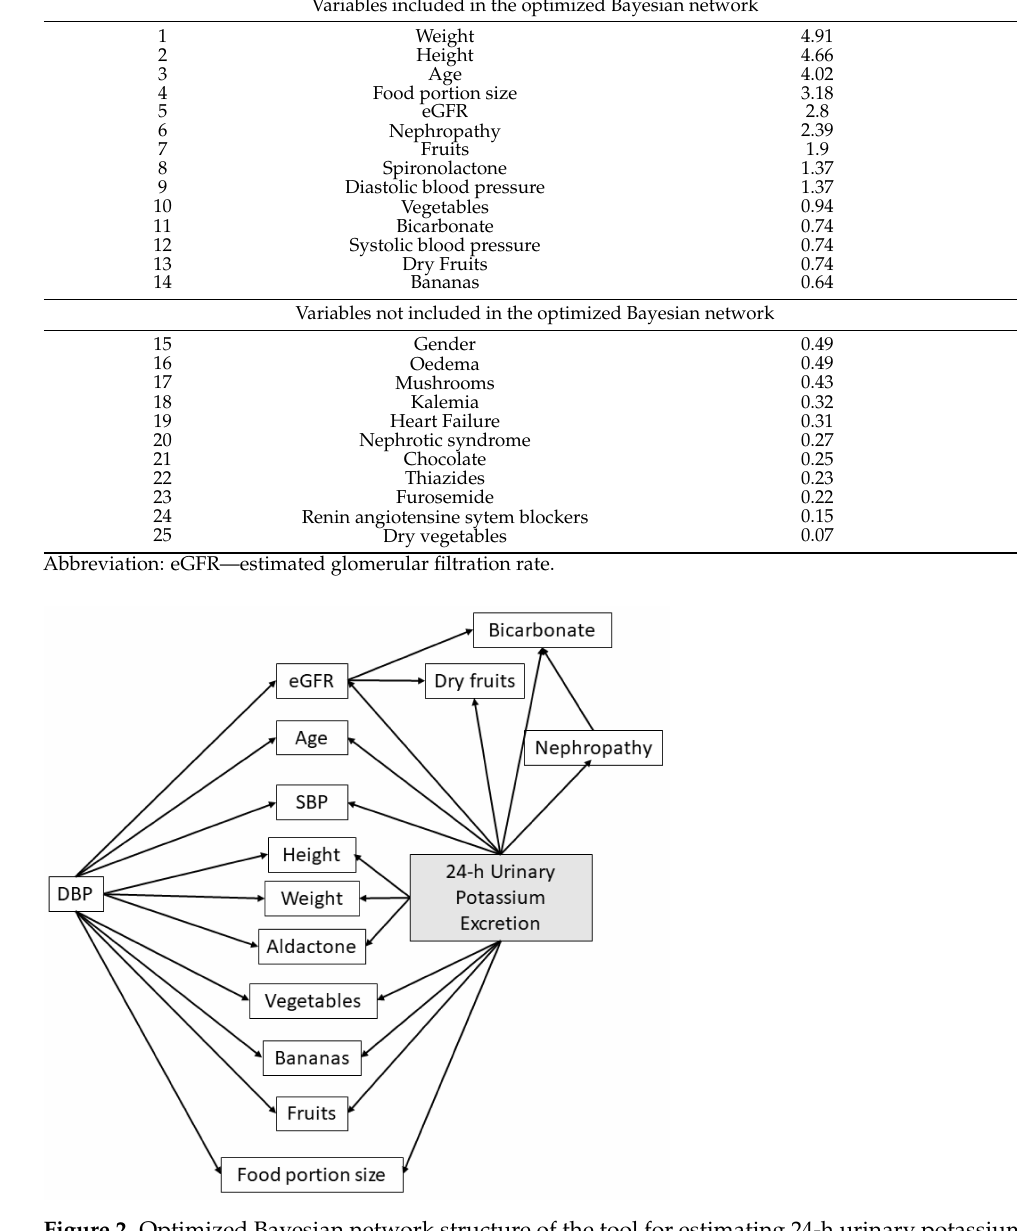
Figure 2. Optimized Bayesian network structure of the tool for estimating 24-h urinary potassium excretion. Abbreviations: eGFR—estimated glomerular filtration rate; DBP—Diastolic Blood Pressure; Nephropathy—nature of the nephropathy; SBP—Systolic Blood